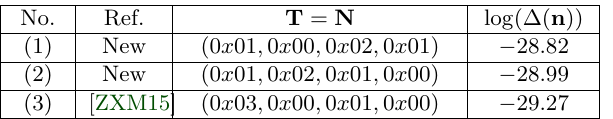
Table 2: The best byte-wise masks ( T , N ) for the linear approximation (2) No. Ref. T = N log(∆( n ))